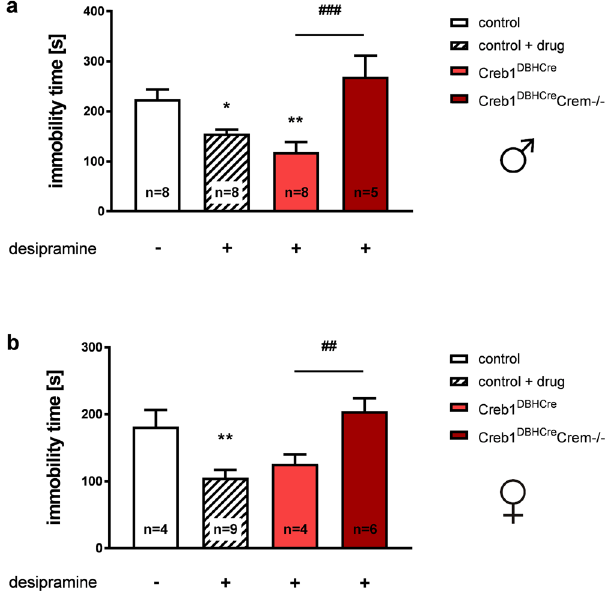
Figure 5. The effect of Creb1 deletion on mouse responsiveness on the TST after desipramine. ( a ) Immobility of control, Creb1 DBHCre , and Creb1 DBHCre /Crem − / − male mice on the TST after desipramine treatment (single dose, 20 mg/kg, i.p., 30 min. prior to the test) (ANOVA: F (3,25) = 9.25, p < 0.001; LSD post-hoc: * p < 0.05, ** p < 0.01 vs control; ### p < 0.001 vs Creb1 DBHCre ). ( b ) Immobility of control, Creb1 DBHCre , and Creb1 DBHCre / Crem − / − female mice on the TST after desipramine treatment (single dose, 20 mg/kg, i.p., 30 min prior to the test) (ANOVA: F (3,19) = 8.71 p < 0.001; LSD post-hoc: ** p < 0.01 vs control; ## p < 0.01 vs Creb1 DBHCre ). Data are the mean ± SEM, n =